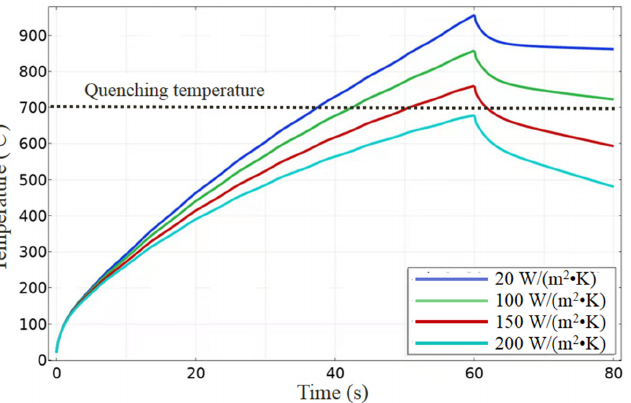
Figure 12. Variations of surface temperature with the time from laser processing. Herein, the heat transfer coefficients were 20 W/(m 2 K) (blue line) for the atmospheric environment condition and 100 W/(m 2 K) (green line), 150 W/(m 2 K) (red line), and 200 W/(m 2 K) (cyan line) for the strong air flow condition.